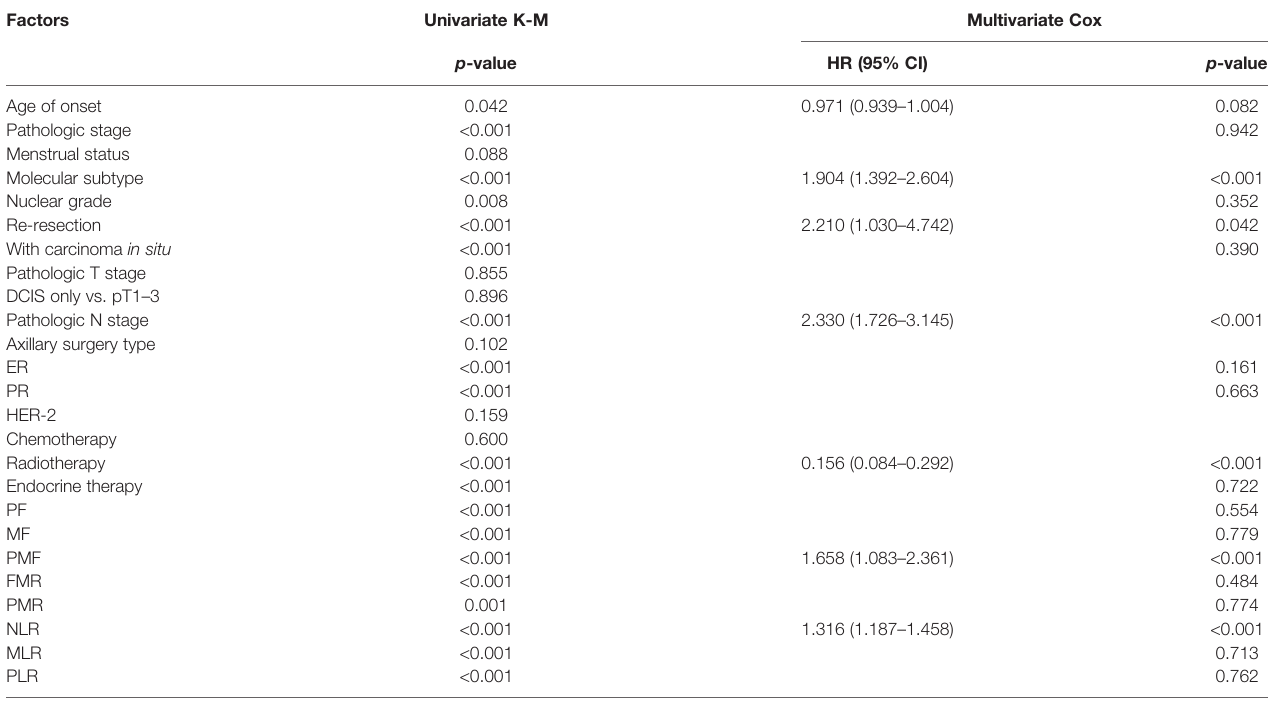
TABLE 3 | Univariate and multivariate analysis of factors for local – regional recurrence.